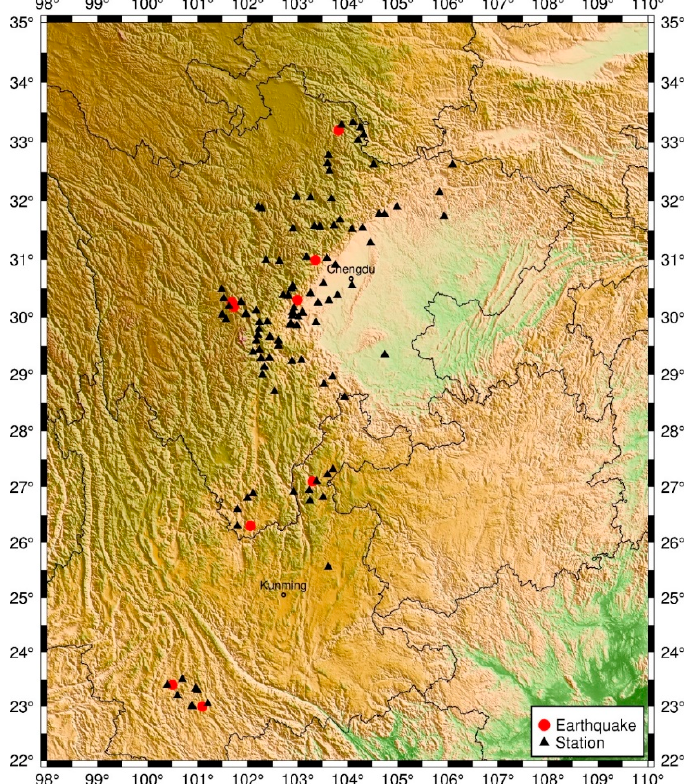
Table 1. Earthquake events in the Sichuan–Yunnan region.